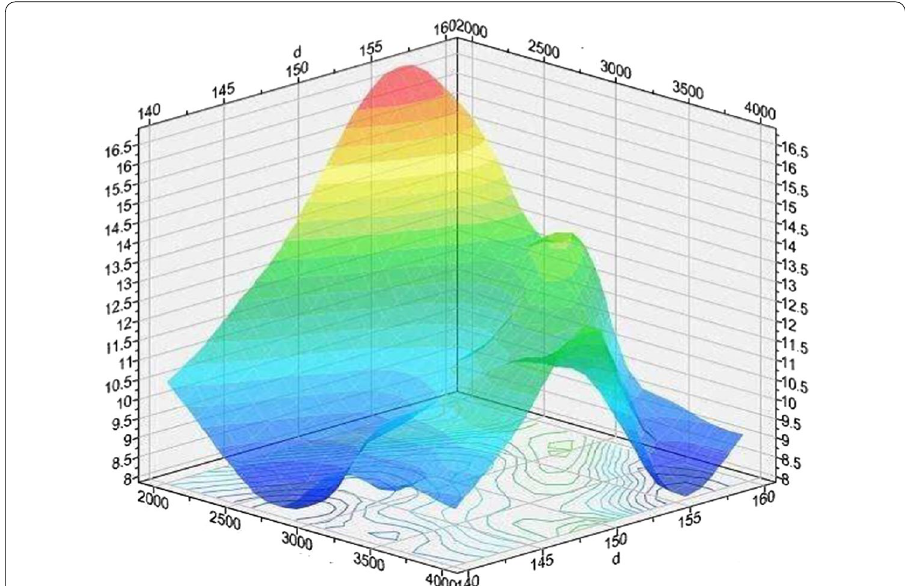
Fig. 4 Editing effect of parametric optimization algorithm on model